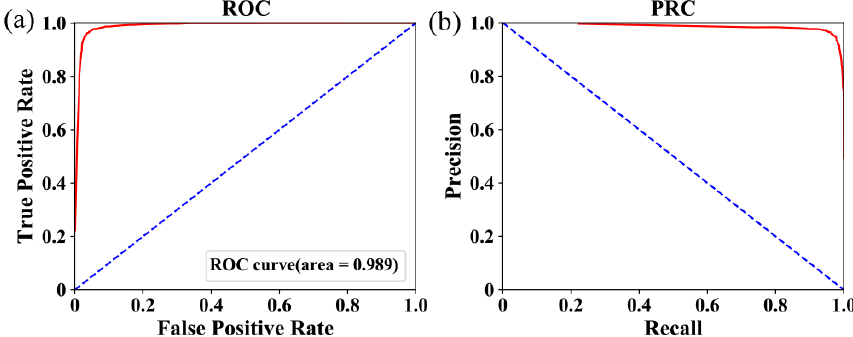
Figure 15. ROC and PRC curves of the TG-1 model for NWPO images during testing process.